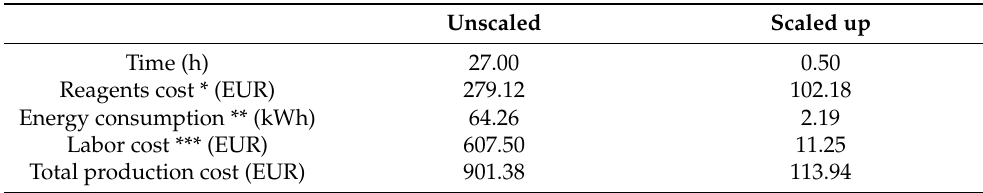
Table 3. Estimation of production cost of 5 g of MNPs by thermal decomposition method under unscaled and scaled